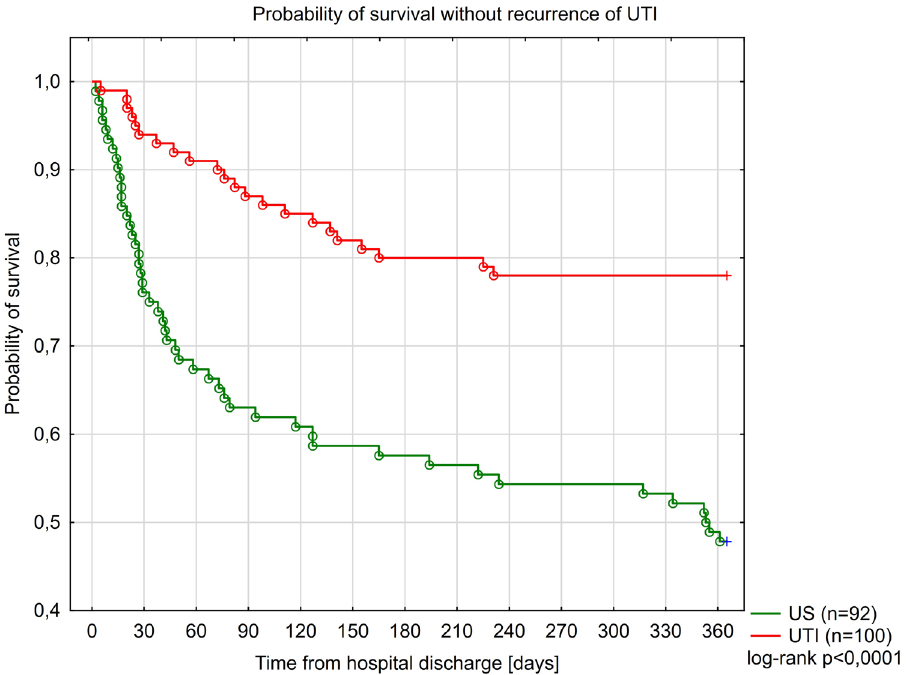
Figure 6. Kaplan Meier curves for survival without recurrence of UTI in the study